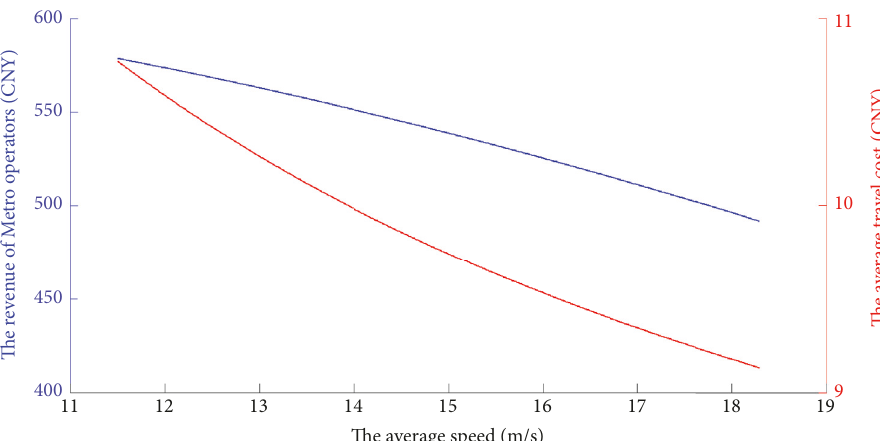
Figure 8: The trade-off between the objective functions and the train average operating speed in the sections.